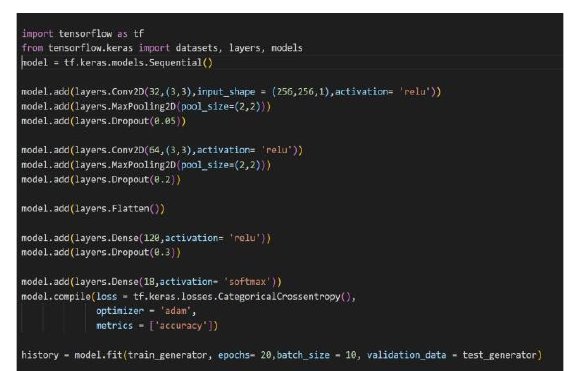
Fig14. Layers applied in the model.